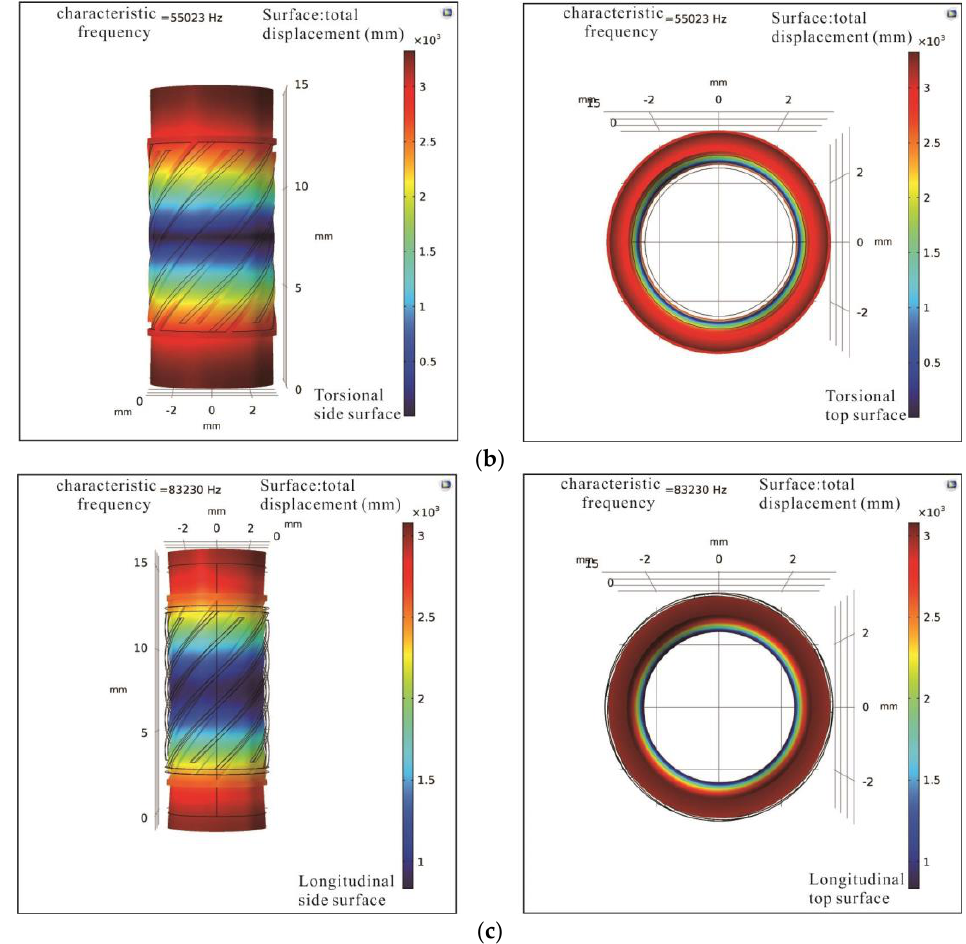
Figure 5. FEM analysis results of the piezoelectric tube actuator showing the side and top view: ( a ) First bending vibration mode of 51.143 kHz; ( b ) First torsional vibration mode of 55.023 kHz; ( c ) First longitudinal vibration mode of 83.230 kHz.